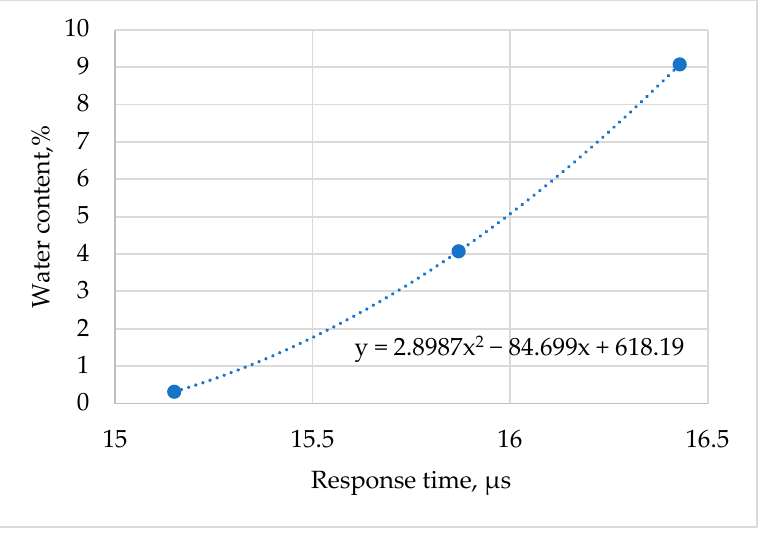
Figure 7. Calibration graph for TDR sensors.